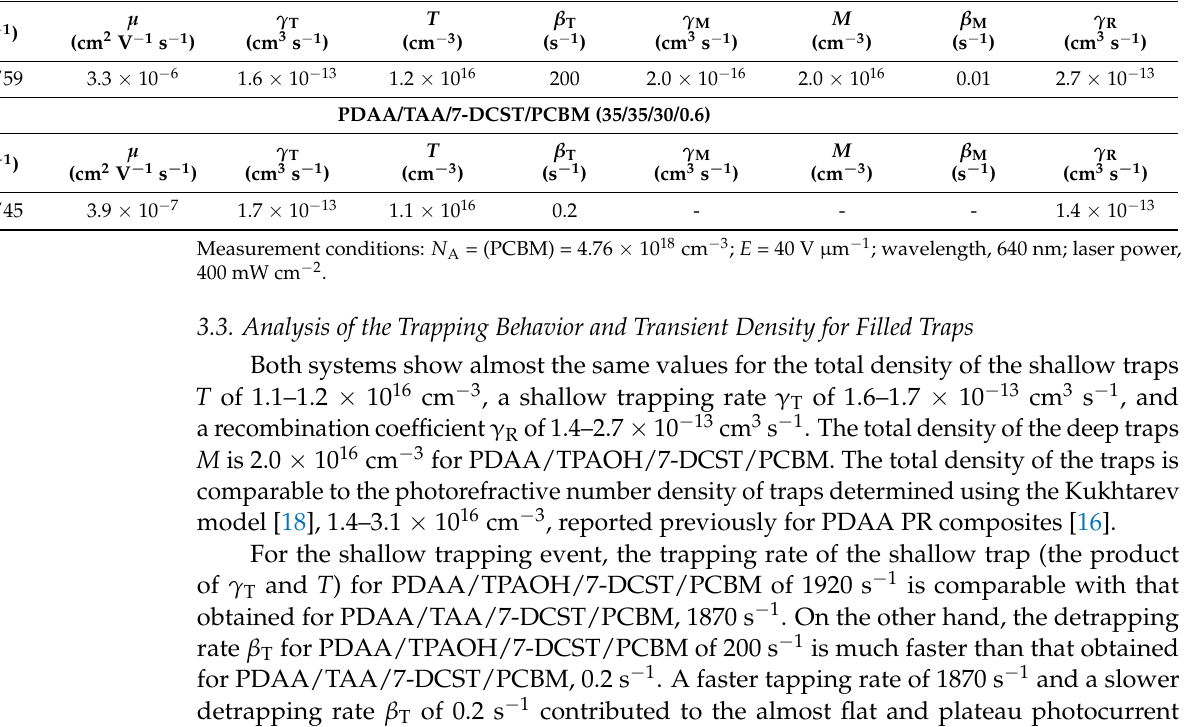
Table 2. Summary of the simulated parameters of quantum efficiency ( QE ) for photocarrier genera- tion, hole mobility, trapping, and recombination parameters for PDAA/TPAOH/7-DCST/PCBM (35/35/30/0.6) and PDAA/TAA/7-DCST/PCBM (35/35/30/0.6). PDAA/TPAOH/7-DCST/PCBM